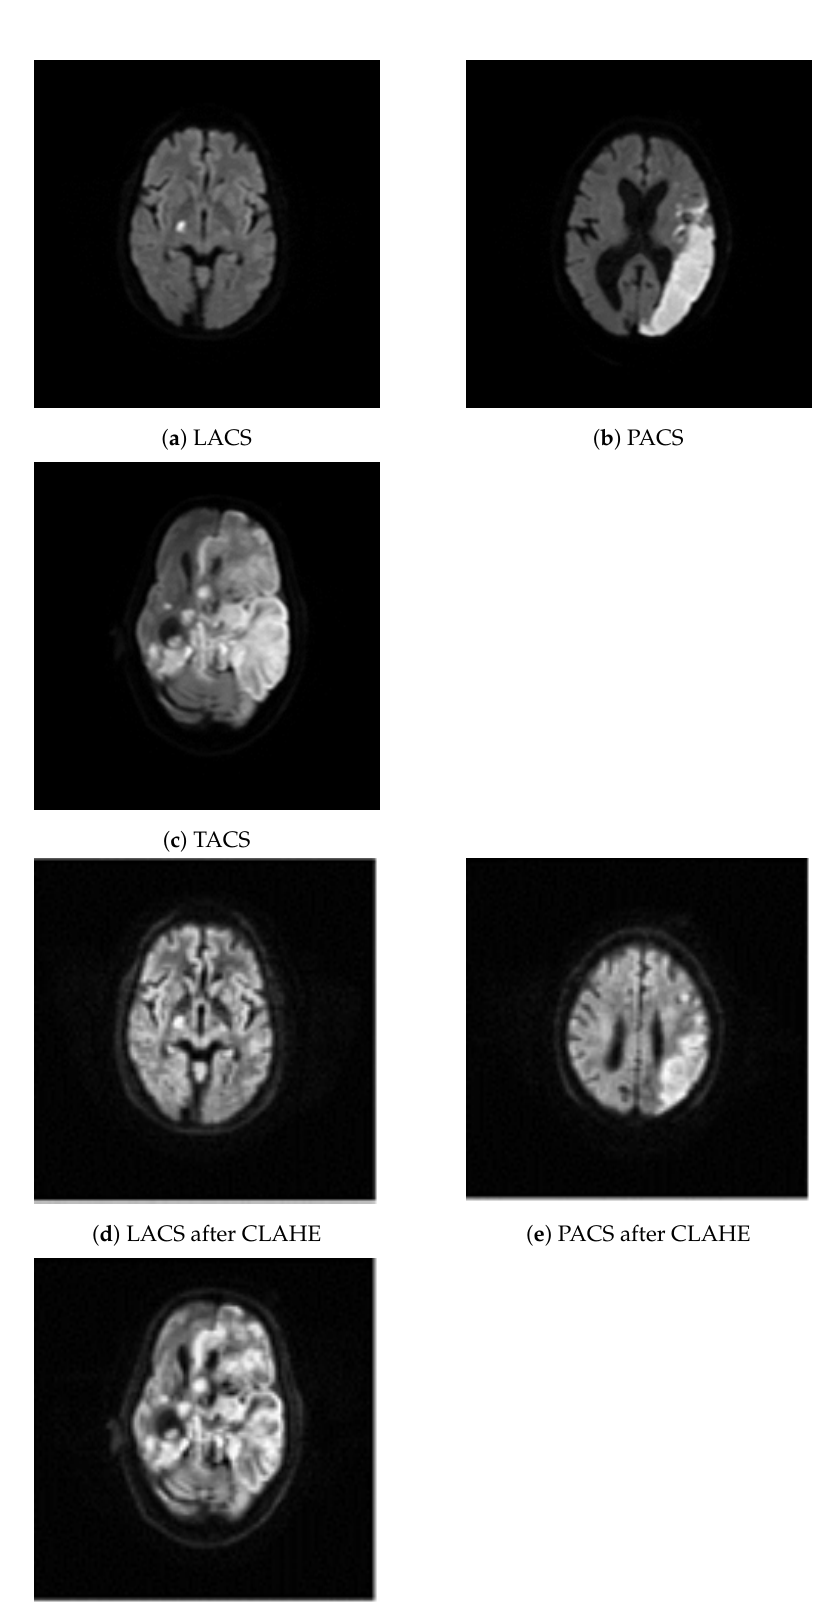
Figure 2. Class specific examples from the image dataset. The original images are shown in the first row: ( a – c ). The images were created by processing the original images with contrast adaptive histogram equalization: ( d – f